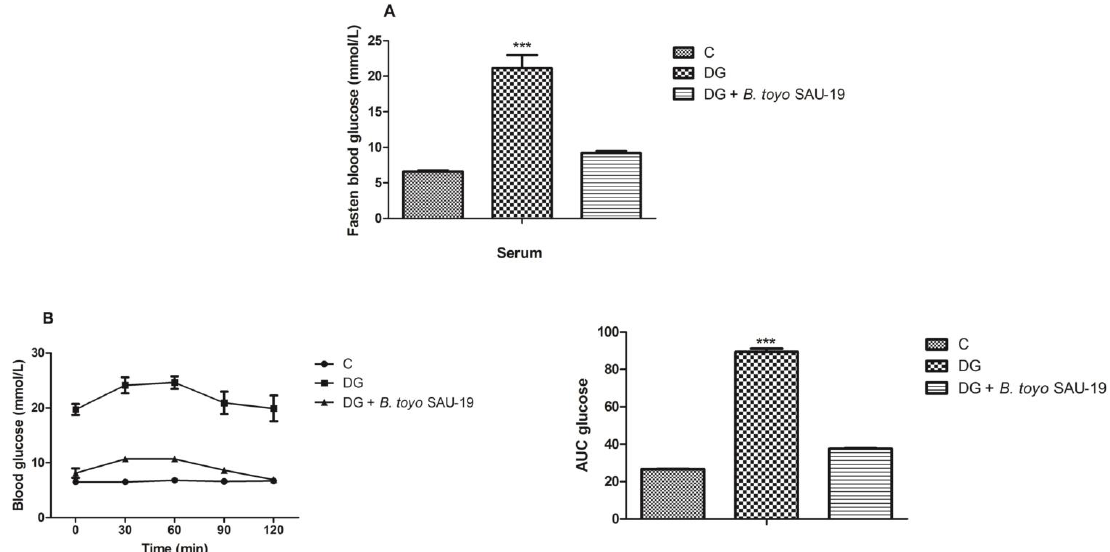
Figure 2. Effects of Bacillus toyonensis SAU-19 on blood glucose tolerance in HFD/STZ-induced T2DM mice. ( A ) Fasted blood glucose (mmol/L). ( B ) Oral glucose test (mmol/L). Values are shown as mean ± Sd. Bars with *** are statistically different ( p < 0.05), DG compared with the control (C) and B. toyo SAU-19 groups ( n = 6).